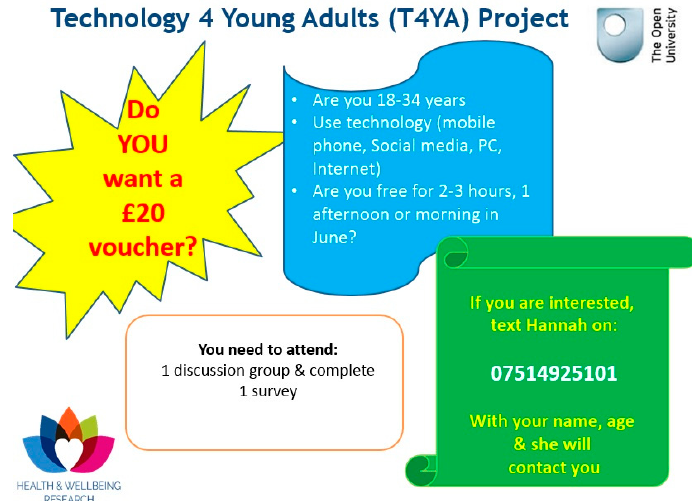
Figure 1. The amended poste r used for participant recruitment.